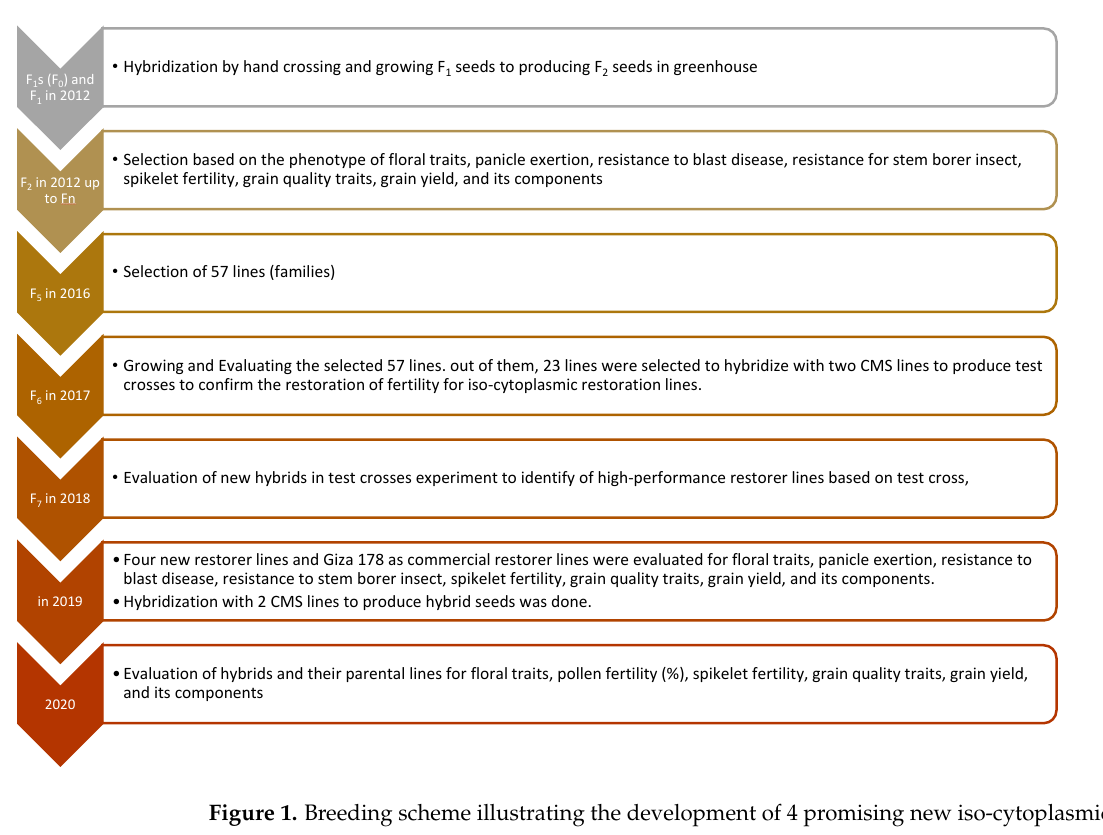
Figure 1. Breeding scheme illustrating the development of 4 promising new iso-cytoplasmic restorer lines in rice through Rice Breeding Program, Rice Research Section, Field Crops Research Institute, Agricultural Research Center, Giza, Egypt.